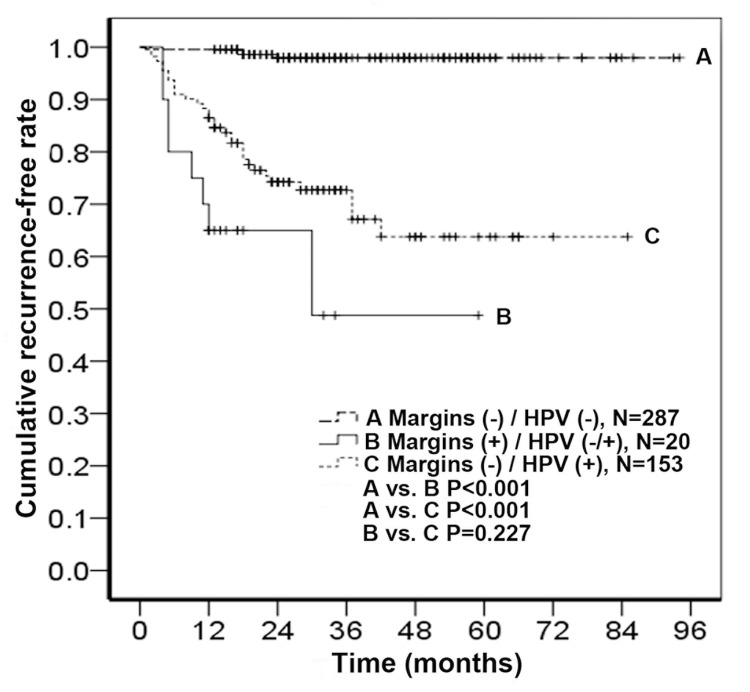
Persistence/recurrence-free rate of women after cervical conization.The patients were divided into three groups according to surgical margin and HPV status.